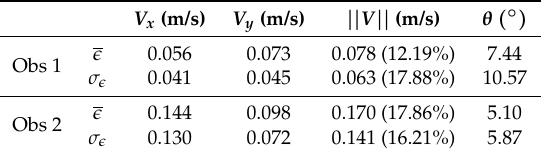
Table 3. Real scenario 2—Errors in velocities detection.